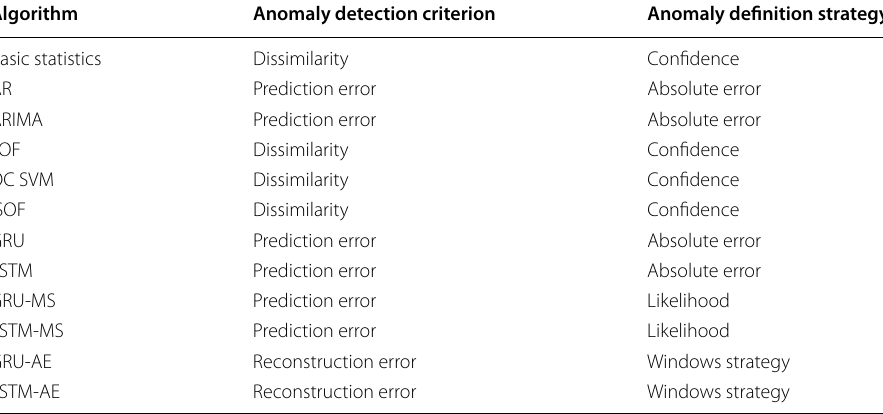
Table 4 Anomaly detection criteria and definition strategies adopted for each algorithm